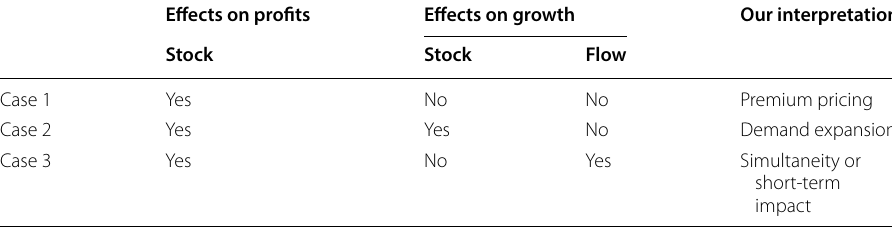
Table 3 Possible results of the multiple regressions and their interpretations Effects on